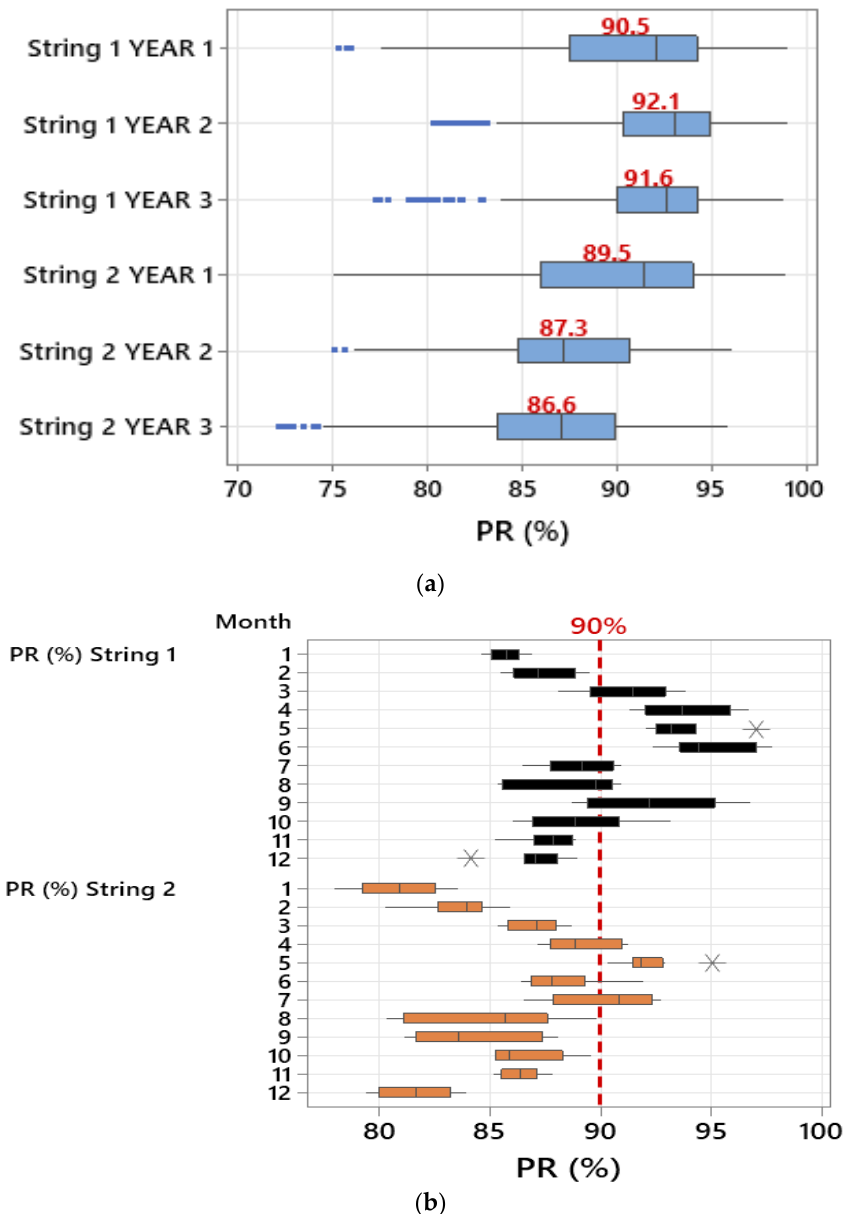
Figure 8. Performance ratio of the tested PV strings over the considered period of the study: ( a ) Boxplot and mean of the PR ratio, ( b ) Boxplot PR vs. months. For the analysis of the performance ratio, data in this particular region (containing symbol " ") can be excluded since they are un- likely to be true.